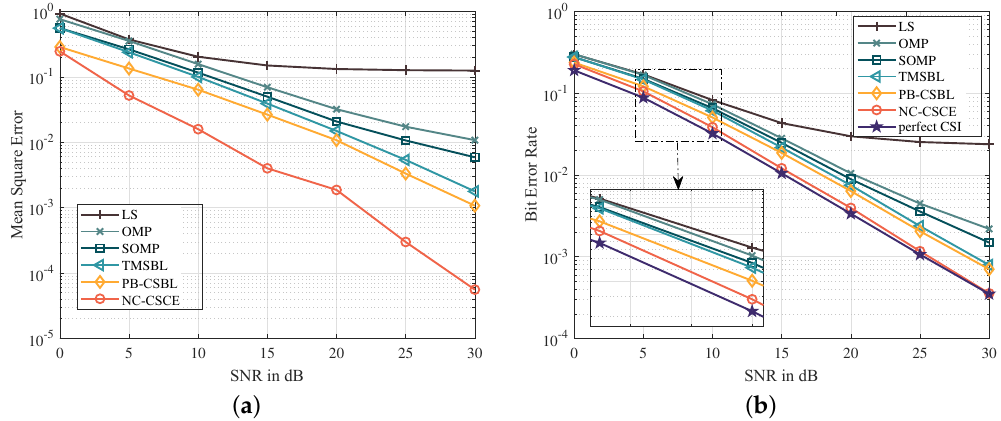
Figure 3. The comparison of MSE and BER performance based on QPSK constellation mapping: ( a ) the comparison of MSE performance; and ( b ) the comparison of BER performance.